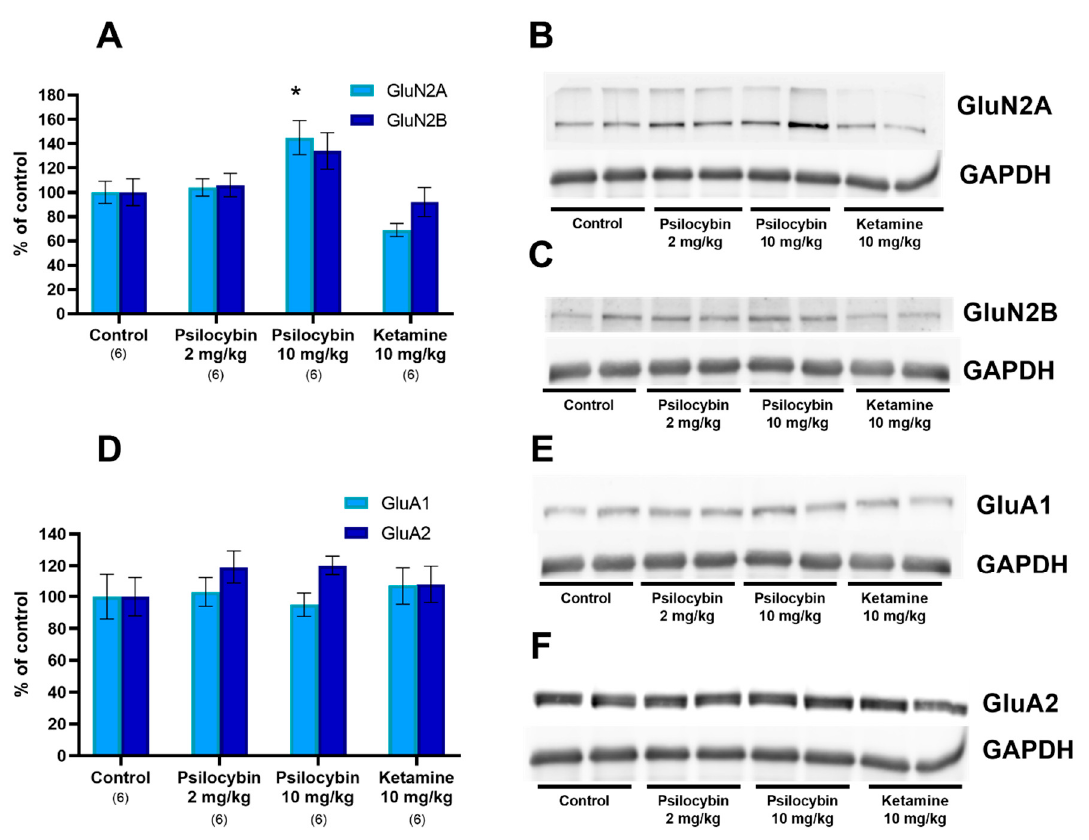
Figure 3. Levels of NMDA receptor subunits (GluN2A and GluN2B; ( A ) and AMPA receptor subunits (GluA1 and GluA2; ( D ) in the rat frontal cortex estimated 24 h after psilocybin (2 and 10 mg/kg) or ketamine (10 mg/kg) administration. The data are shown as percentages of the levels of the appropriate control groups. Each data point represents the mean ± SEM (n is given under the name of the group). Only in group GluN2A are data given in duplicates. * p < 0.05 vs. appropriate control group (one ‐ way ANOVA followed by Tukey’s post hoc test). Examples of photomicrographs of the immunoblots using GluN2A and GAPDH antibodies ( B ), GluN2B and GAPDH antibodies ( C ), GluA1 and GAPDH antibodies ( E ) and GluA2 and GAPDH antibodies ( F ).